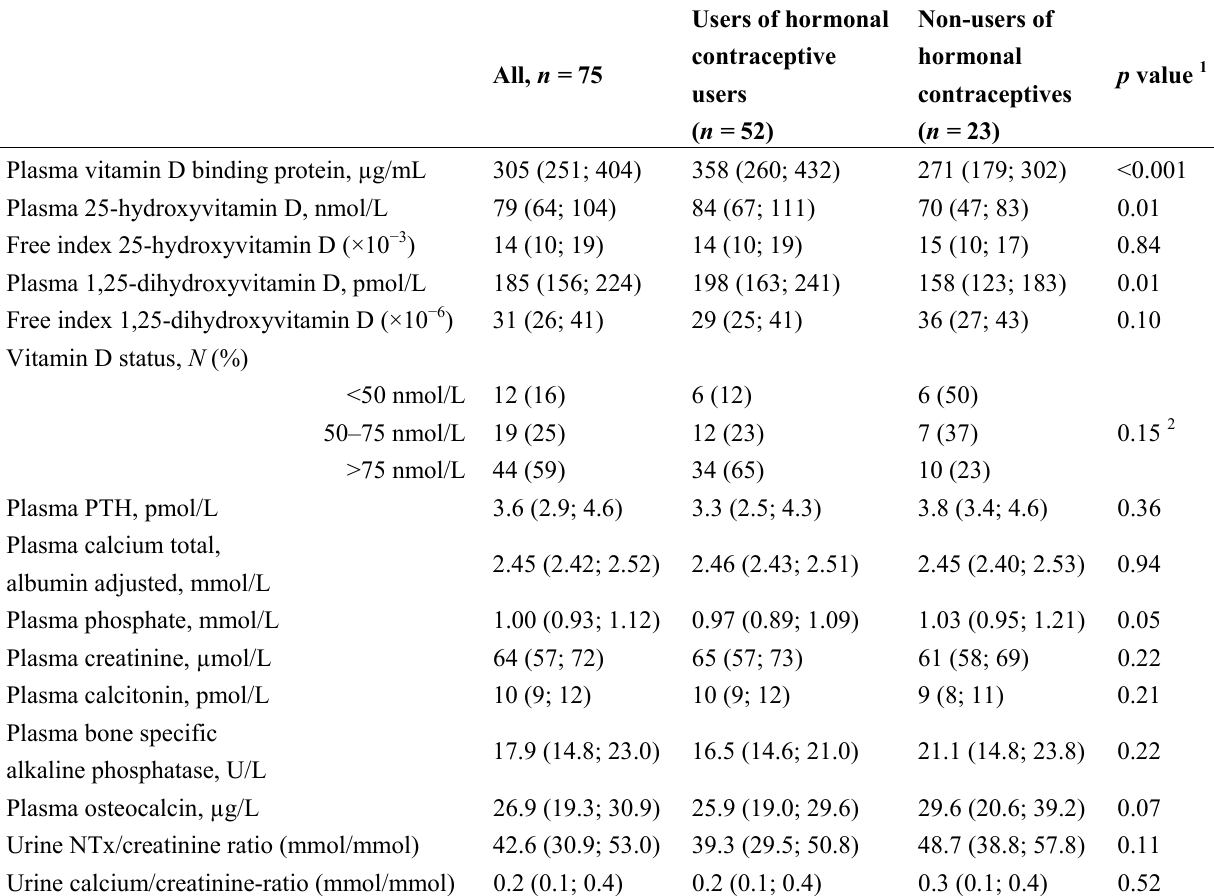
Table 2 details the biochemical indices measured as stratified by whether studied women used HC. Table 2. Biochemical characteristics as stratified by use of hormonal contraceptives. Data are presented as Median with interquartile (p25; p75) ranges unless otherwise